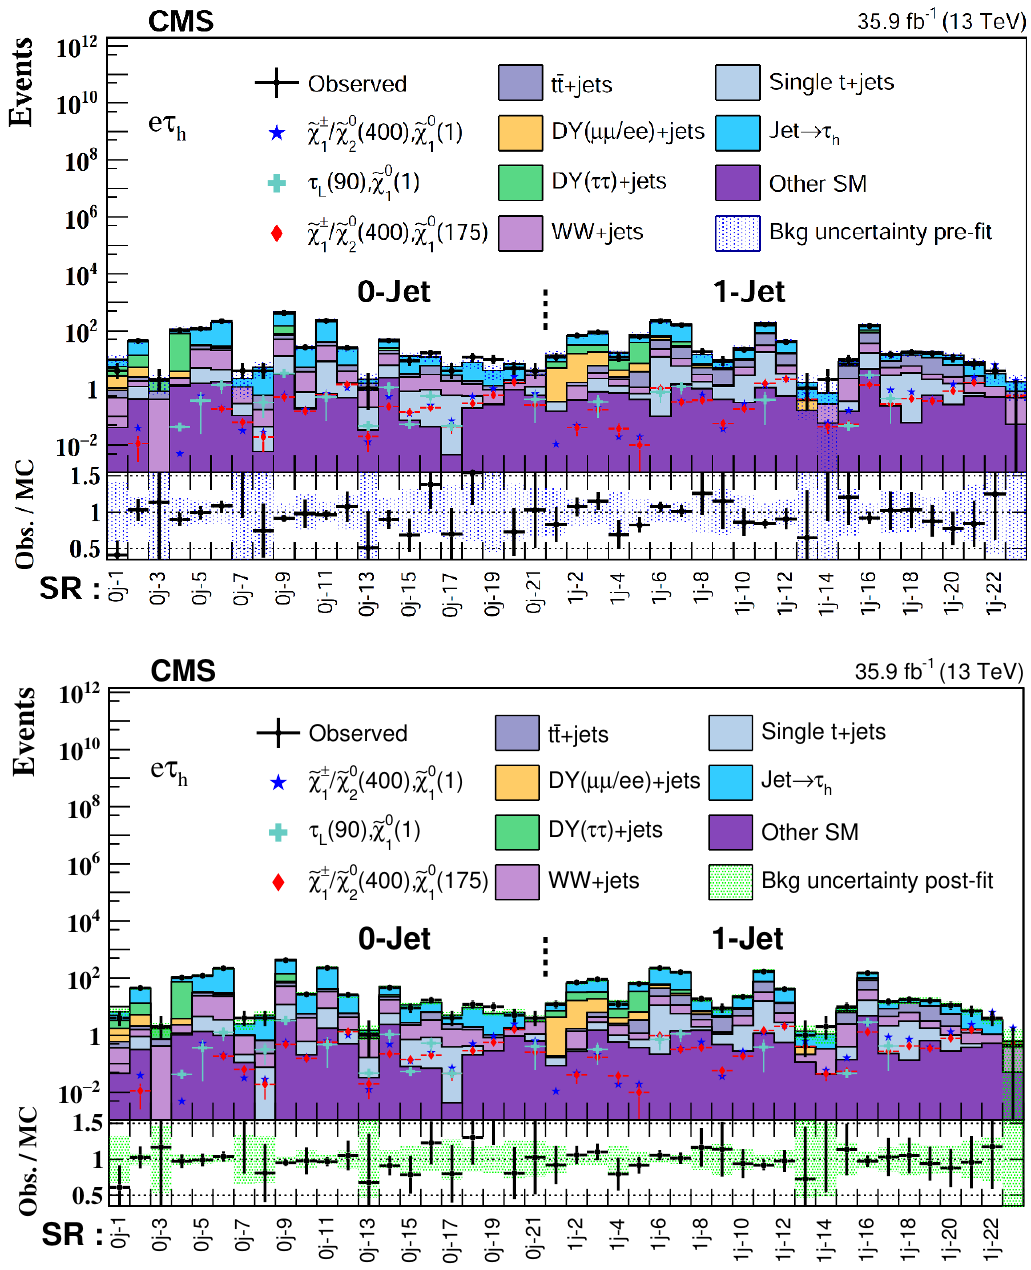
Figure 8. Pre-(cid:12)t (upper) and post-(cid:12)t (lower) results for the SRs used for the (cid:12)nal signal extraction in the e (cid:28) h (cid:12)nal state. Distributions for two benchmark models of chargino-neutralino production, and one of direct left-handed (cid:28) pair production, are overlaid. The numbers within parentheses in the legend correspond to the masses of the parent SUSY particle and the (cid:31) 0 in GeV for these 1 benchmark models. In the ratio panels, the black markers indicate the ratio of the observed data e in each SR to the corresponding pre-(cid:12)t or post-(cid:12)t SM background prediction. e